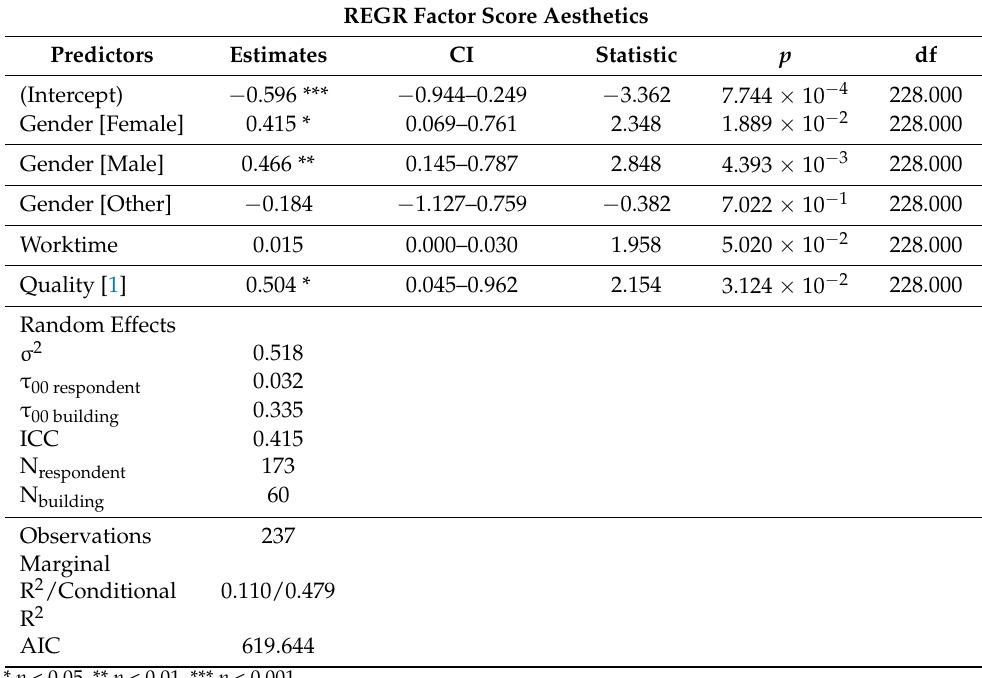
Table 16. Regression model for Aesthetics.